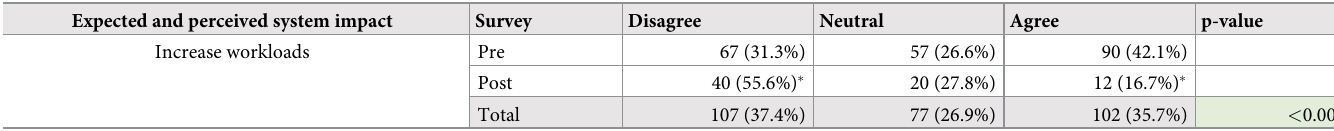
Table 5. Expected and perceived impact of consumer escalation system